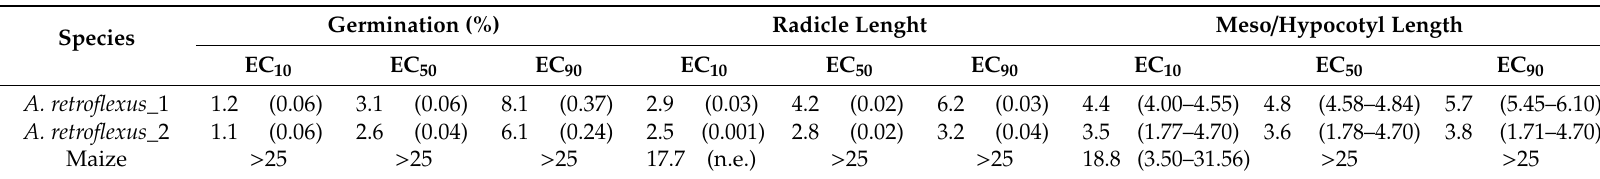
Table 2. EC 10 , EC 50 and EC 90 values (% w / v ) of aqueous extracts of mugwort, on seed germination, radicle and meso / hypocotyl length of maize and redroot pigweed ( A. retroflexus ) (1 and 2 mean the two repeated bioassays) seedlings (standard errors and confidential intervals are in parentheses; n.e.: not